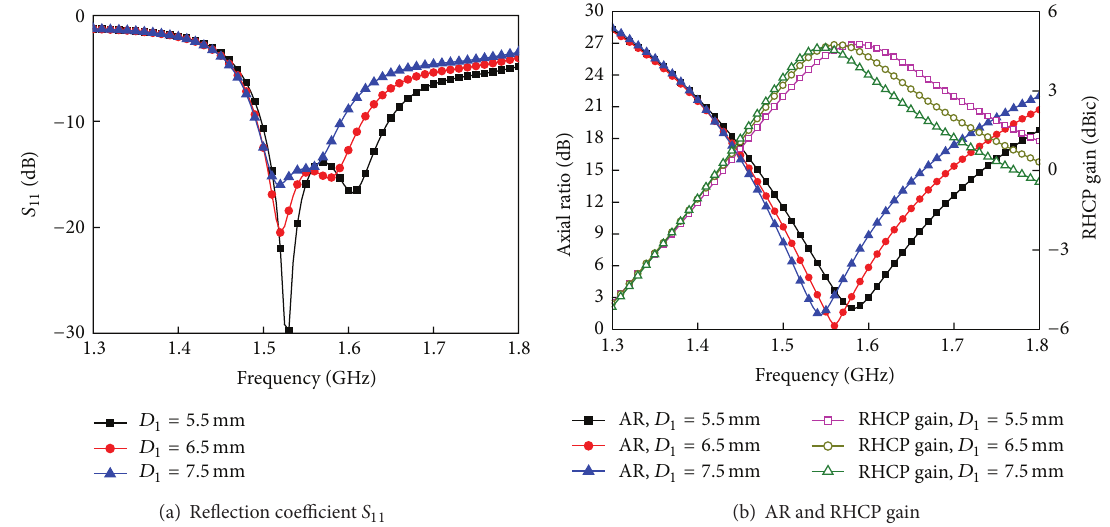
Figure 5: Effect of the height of air gap 𝐷 1 on the reflection coefficient, gain, and axial ratio of the antenna.